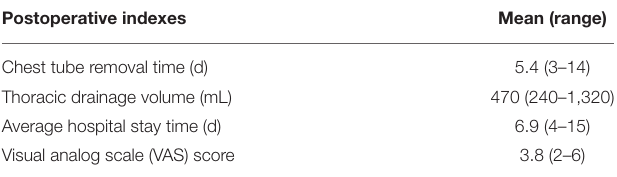
TABLE 4 | Postoperative recovery situation of patients.